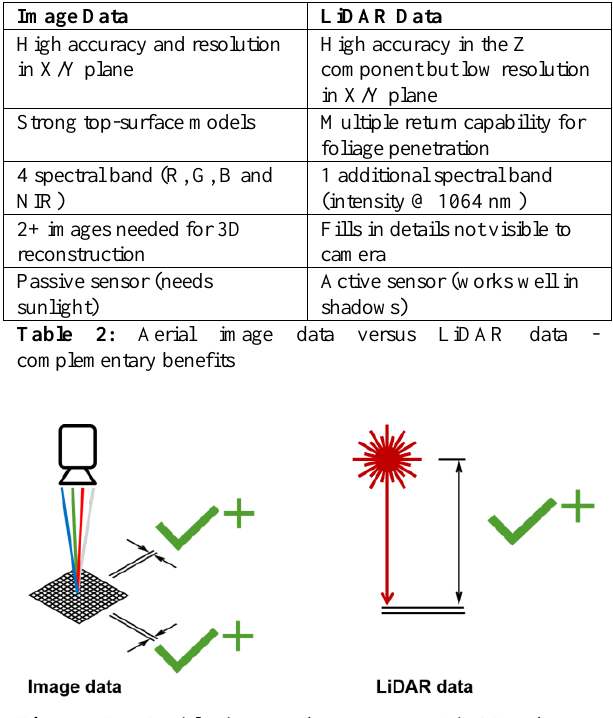
Figure 5: Aerial image data versus LiDAR data